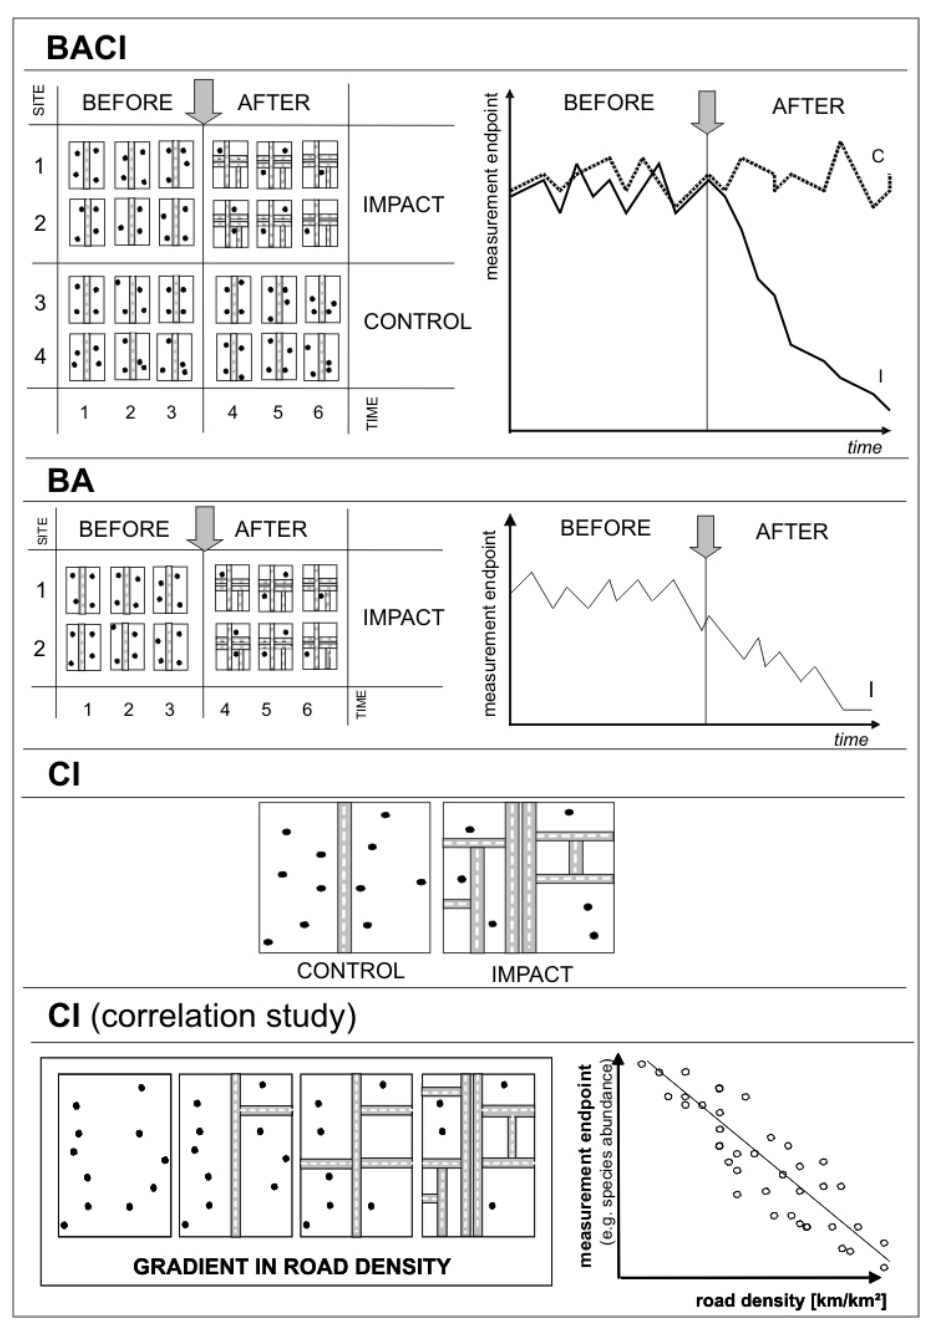
Fig. 7 . Study designs and hypothetical results for Question 5: Under what circumstances do road networks affect population persistence at the landscape scale? The study types include before-after- control-impact (BACI), before-after (BA), and control-impact (CI) designs. The correlation study is a subtype of the CI